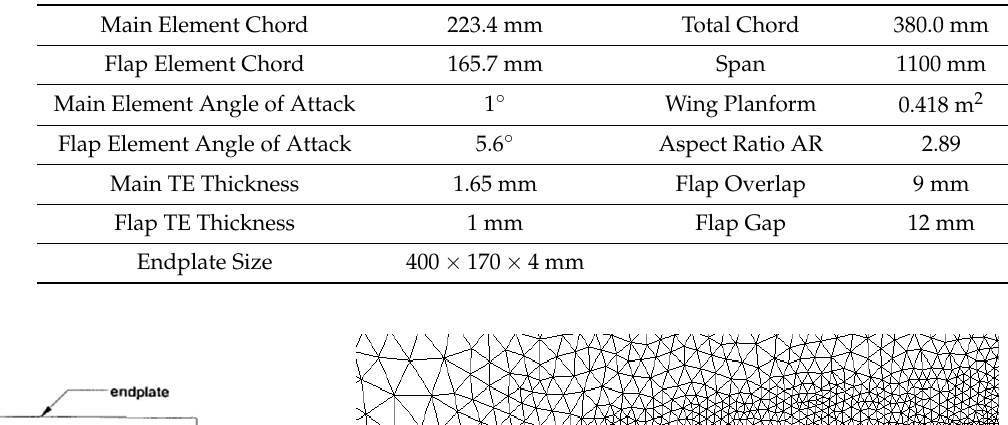
Table 1. Dimensions of a double-element wing.